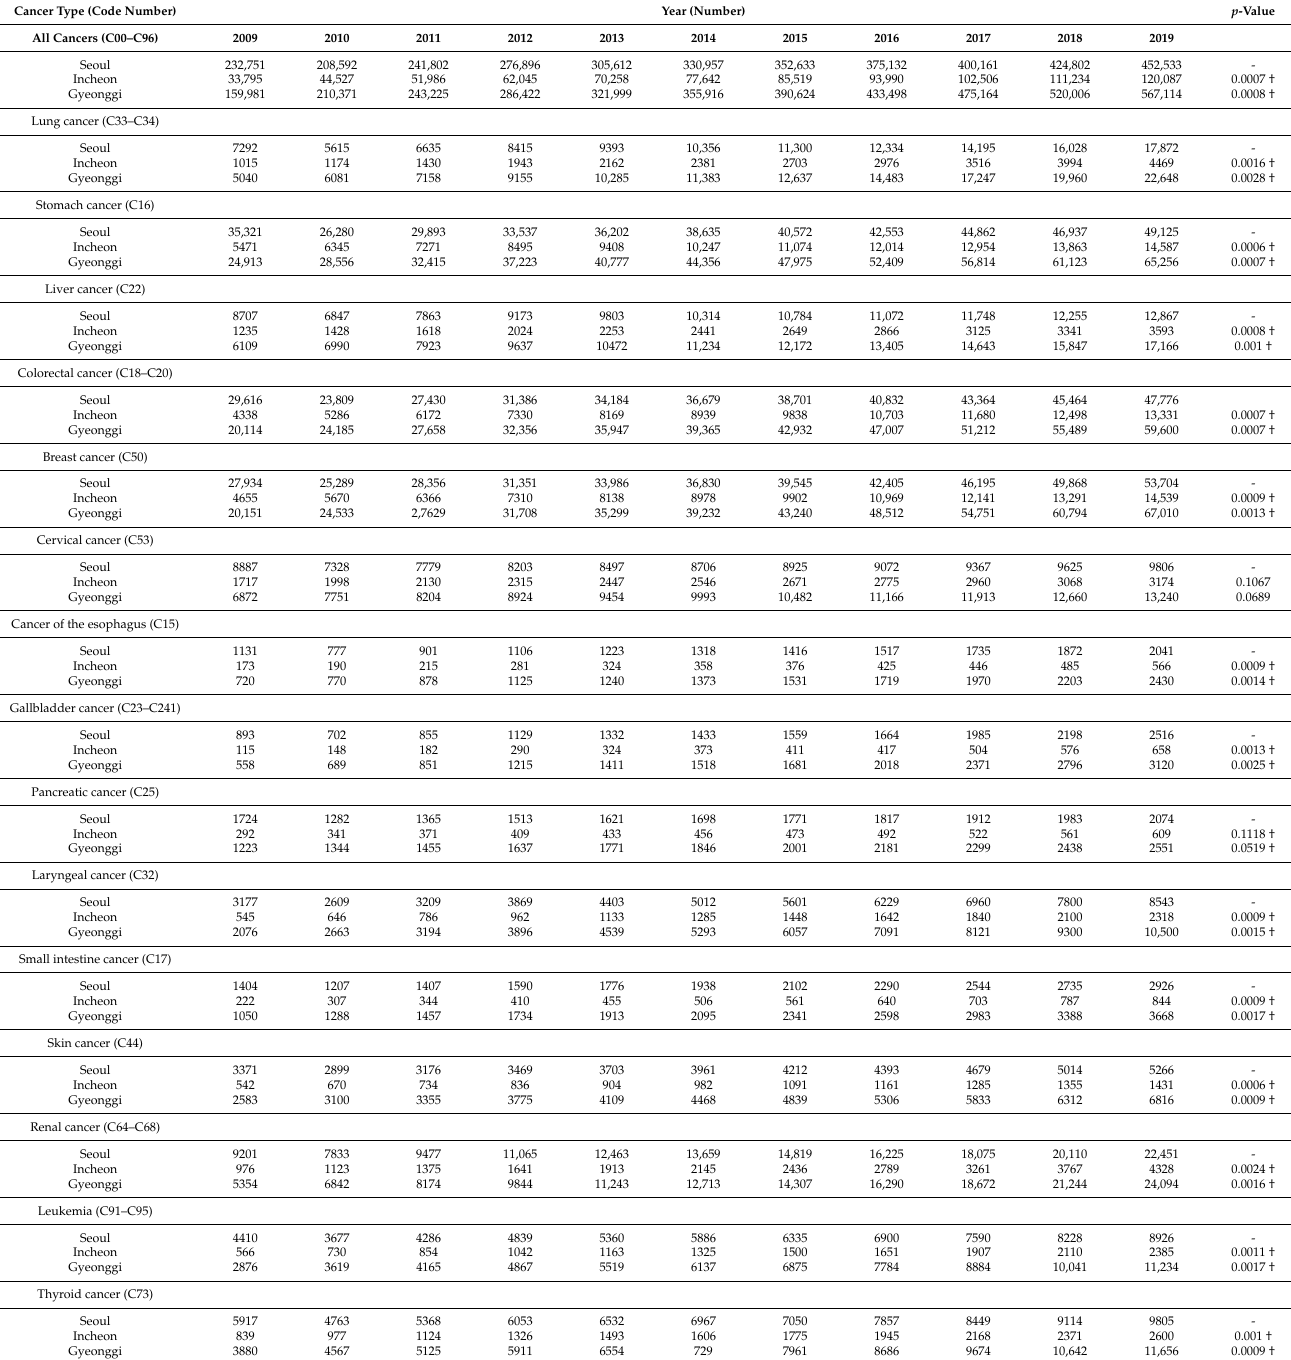
Table 6. Risk ration of major cancers according to the fine dust policy in the downtown area of